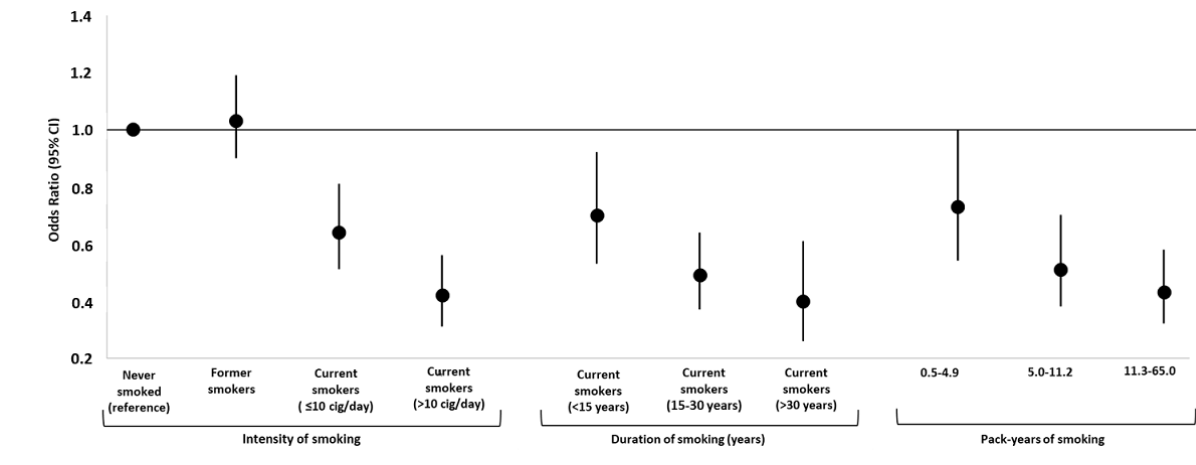
Figure 3. Adjusted odds ratios for positive SARS-CoV-2 tests by smoke-related variables: intensity, duration, and pack-years of smoking (N=6857). Odds ratios were adjusted for age, sex, education, occupation, area of residence, heart diseases, lung diseases, hypertension, metabolic and oncological diseases, contact with COVID-19 cases, living area, crowding index, and living with at-risk cohabitants. Dots and vertical lines indicate adjusted odds ratios and 95% CIs, respectively. cig: